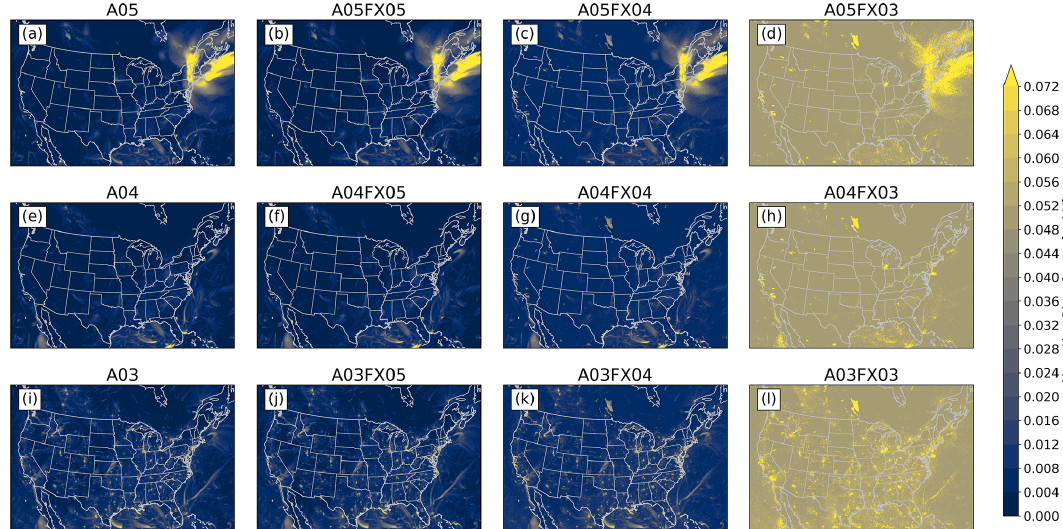
Figure 8. Maximum absolute bias (versus the orig simulation) for O 3 calculated from hourly output for all simulations and cases.